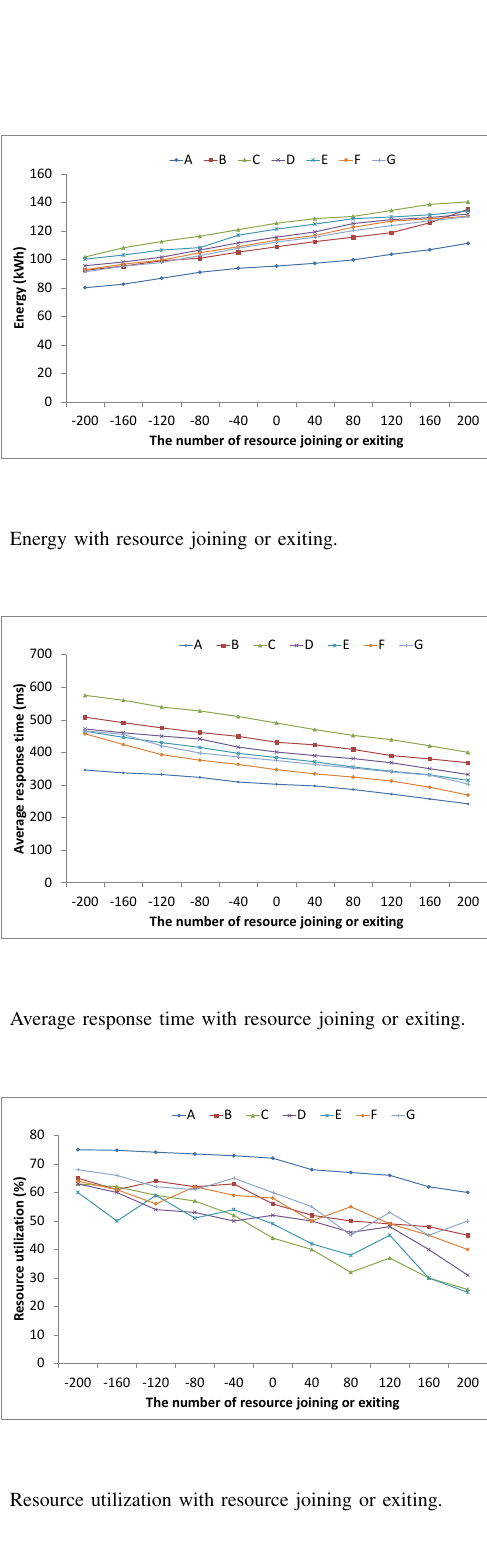
Fig. 3. Resource utilization with resource joining or